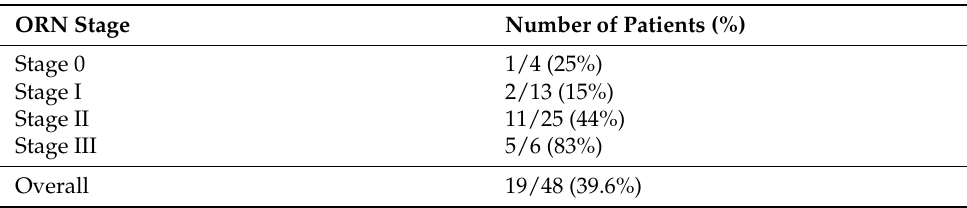
Table 4. Percentage of trismus in the ORN stage.